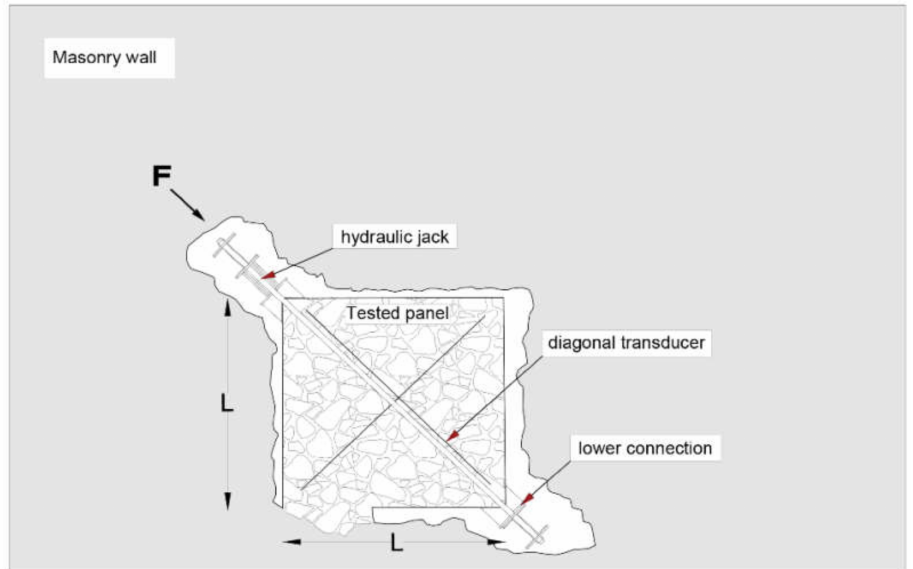
Figure 2. Typical test arrangement for in situ diagonal compression test of masonry